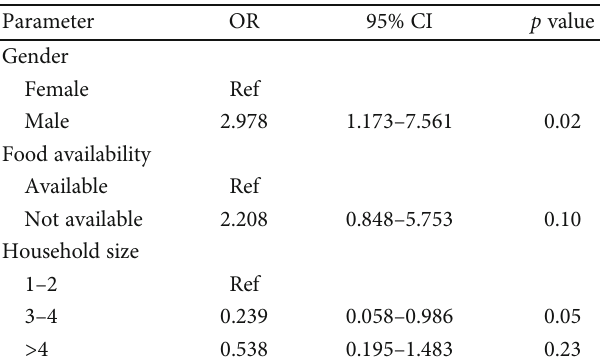
Table 4: Logistic regression analysis of factors in fl uencing treatment